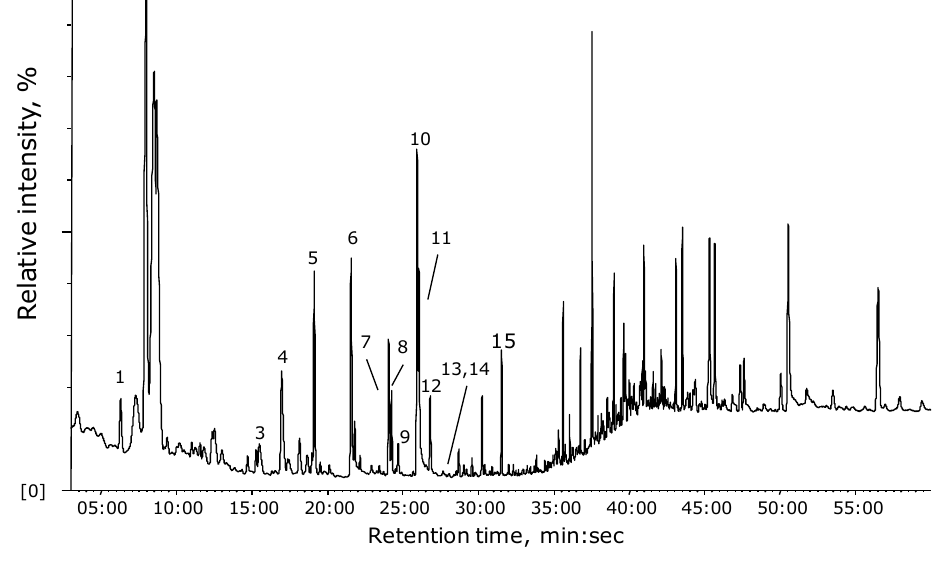
Figure 2. Typical (selected ions) chromatogram of volatile compounds released from 5  L of blood plasma during drying in pure He gas. VOCs collected in a small sorption tube filled with Tenax GR and subsequently thermally desorbed into the GC-MS system by the means of Curie point flash pyrolysis. Ions m/z = 43, 44, 56, 57, 60, 67, 72, 80, 84, 91, 104, 105, 106, and 108 used for